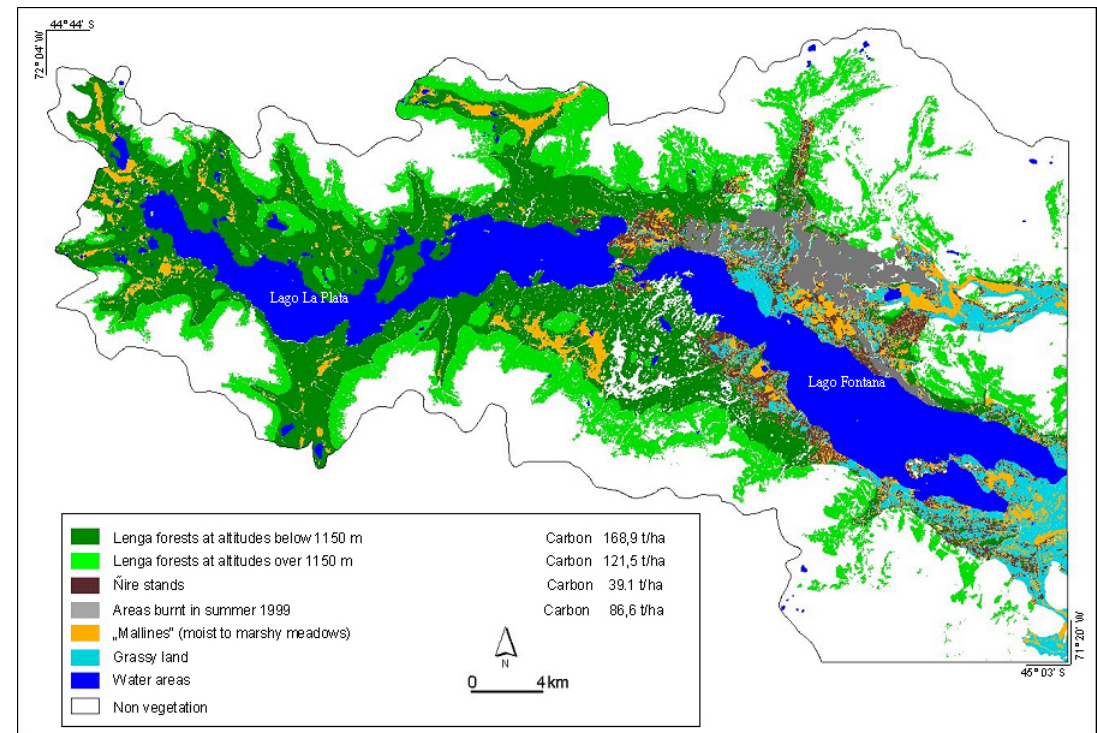
FIGURE 11 . Mean volume of C in the project